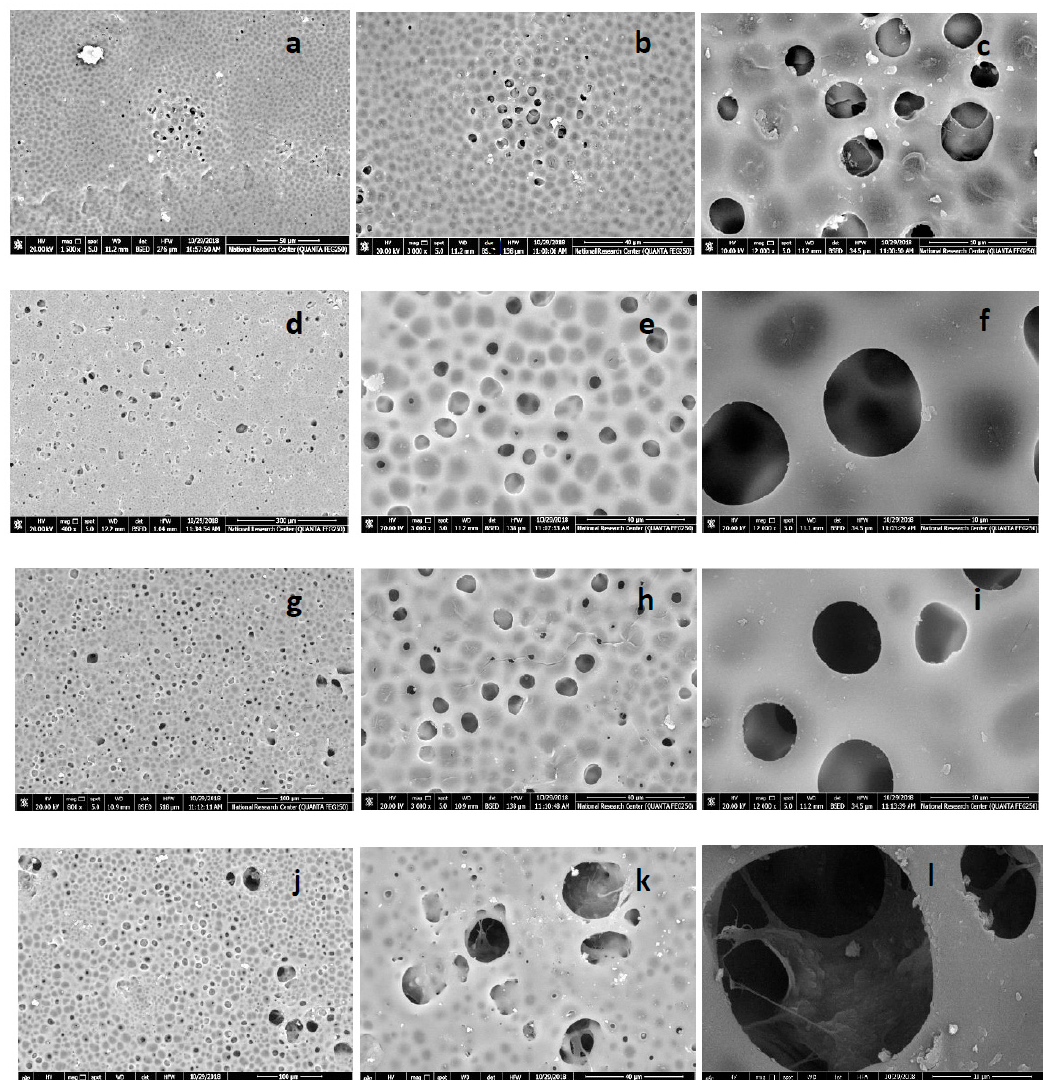
Figure 3. SEM image of surfaces of PSF ( a – c ), PSF/0.5% RSNF ( d – f ), PSF/1% RSNF ( g – i ), and PSF/2%